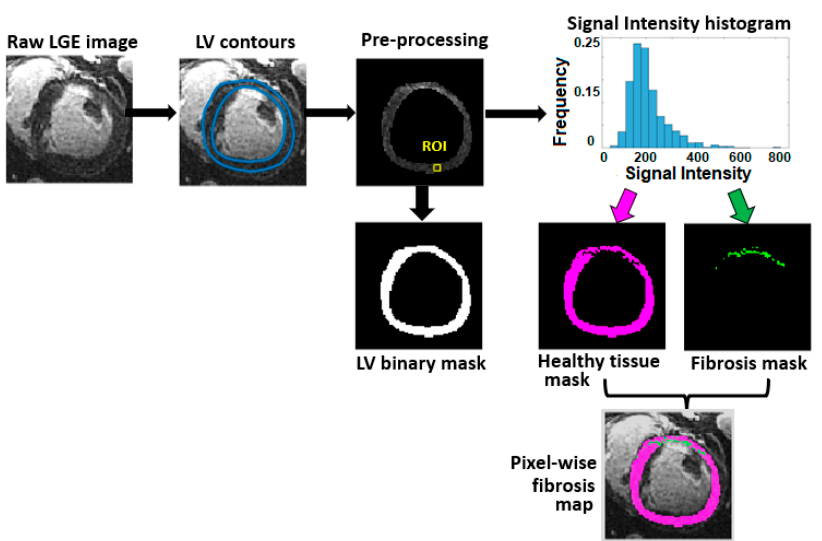
Figure 3. Diagrammatic illustration of the analysis pipeline used to generate pixel-wise fibrosis maps from high resolution LGE images (see text for more details). Note: fibrosis pixels are represented in green and healthy myocardium pixels in magenta.